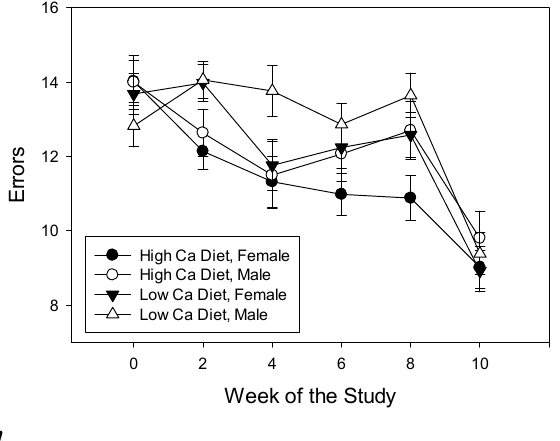
Figure 3. Mean (± SE) number of errors made by least shrews maintained on mealworm diets with different calcium content.